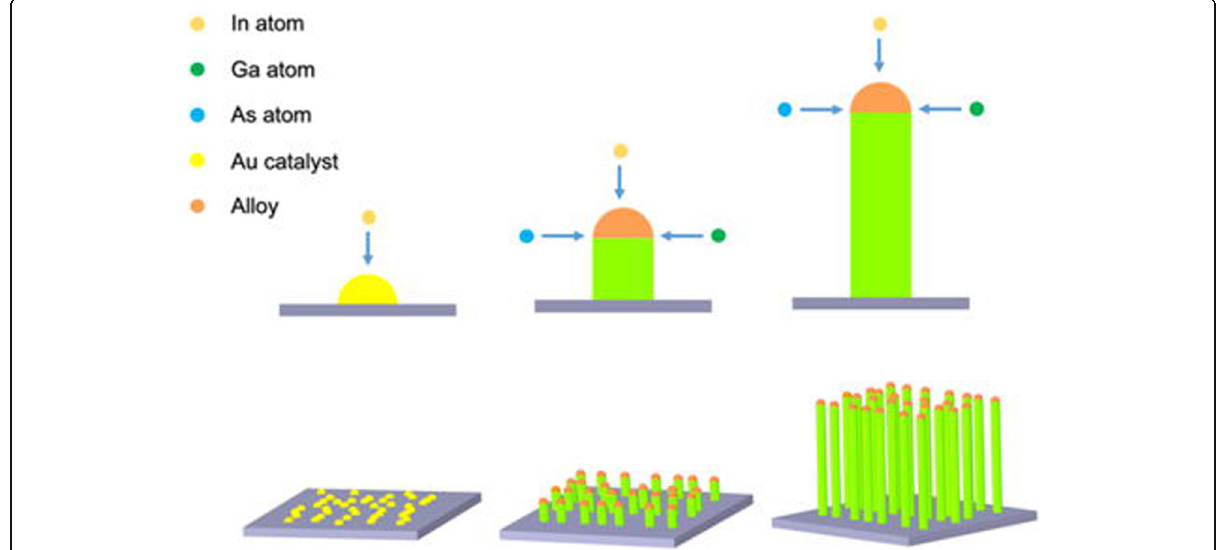
Fig. 7 Schematic diagram of the VLS growth mechanism of InGaAs NWs in our